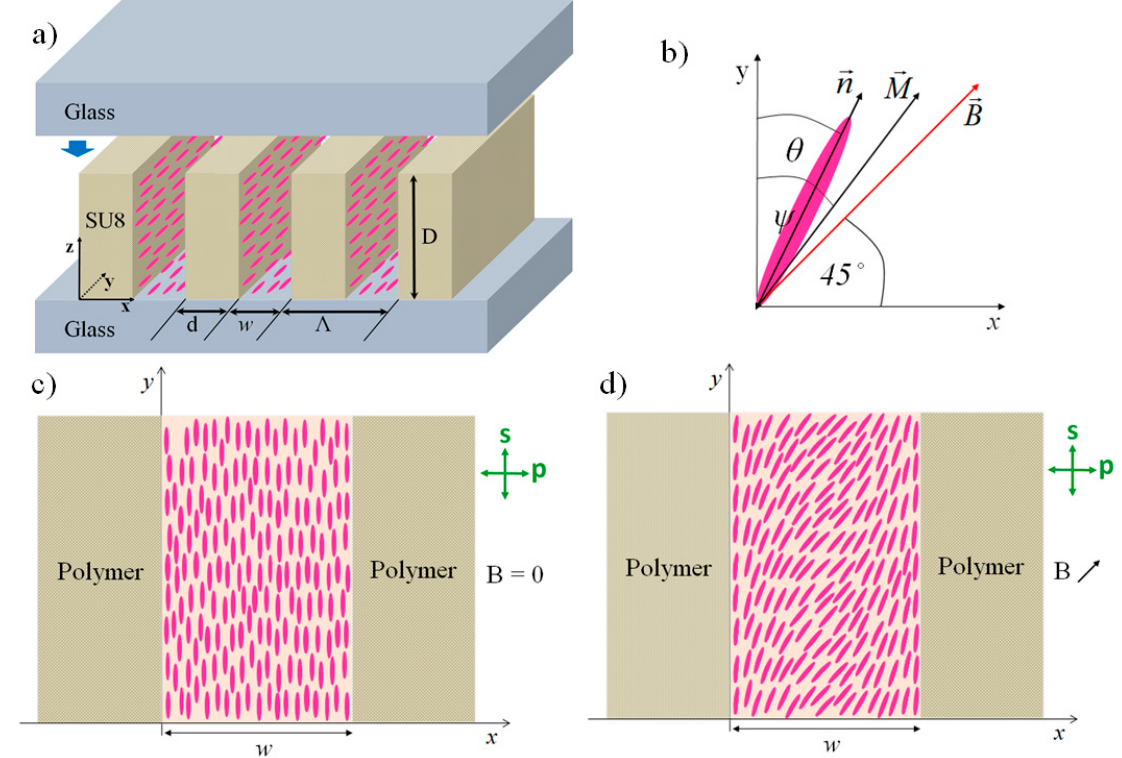
Figure 1. ( a ) Schematic drawing of the periodic assembly of liquid crystal (LC) channels separated by polymeric ribbons fabricated from the photoresist polymer SU-8. Stripes indicate polymer ribbons, and pink ellipsoids indicate the LC molecules. ( b ) Local orientation of the nematic director n and of the magnetization M under the influence of the external magnetic field B is indicated, where θ ( x ) and ψ ( x ) indicate inclination angles of n and M with respect to the y -axis, respectively. ( c ) Schematic drawing of the homogeneous alignment of the LC medium between two polymer ribbons at B = 0. Alignment along the y -axis is induced by the surface relief structure present on the sidewalls of the ribbons. ( d ) Schematic drawing of the in-plane reorientation of the LC molecules induced by an external magnetic field tilted at 45° with respect to the y -axis. Green arrow-ended lines on the right side of the drawings indicate two orthogonal linear polarizations for optical radiation propagating along the z -axis that are customarily denoted as s- and p-polarization.